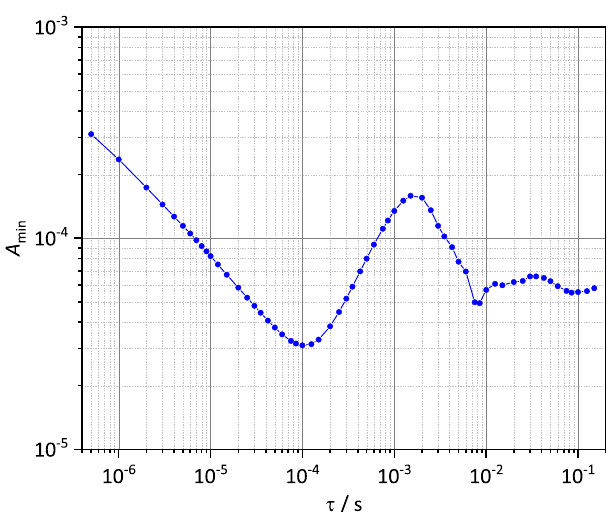
Figure 4. Minimum detectable absorption as function of the time resolution τ for typical measurement conditions (790 kHz bandwidth, 700 µW light power on the detector, I 0 = 1.2 V, ∆ f = 0.6, G = 200, ˜ ν = 3228.05 cm − 1